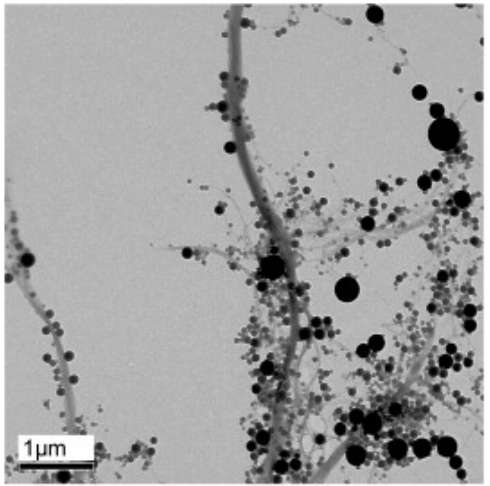
Figure 4. Hydrophobin coated itraconazole nanocrystals attached to a nanofibrillar cellulose network (reprinted from [6] with permission. Copyright Elsevier 2011).